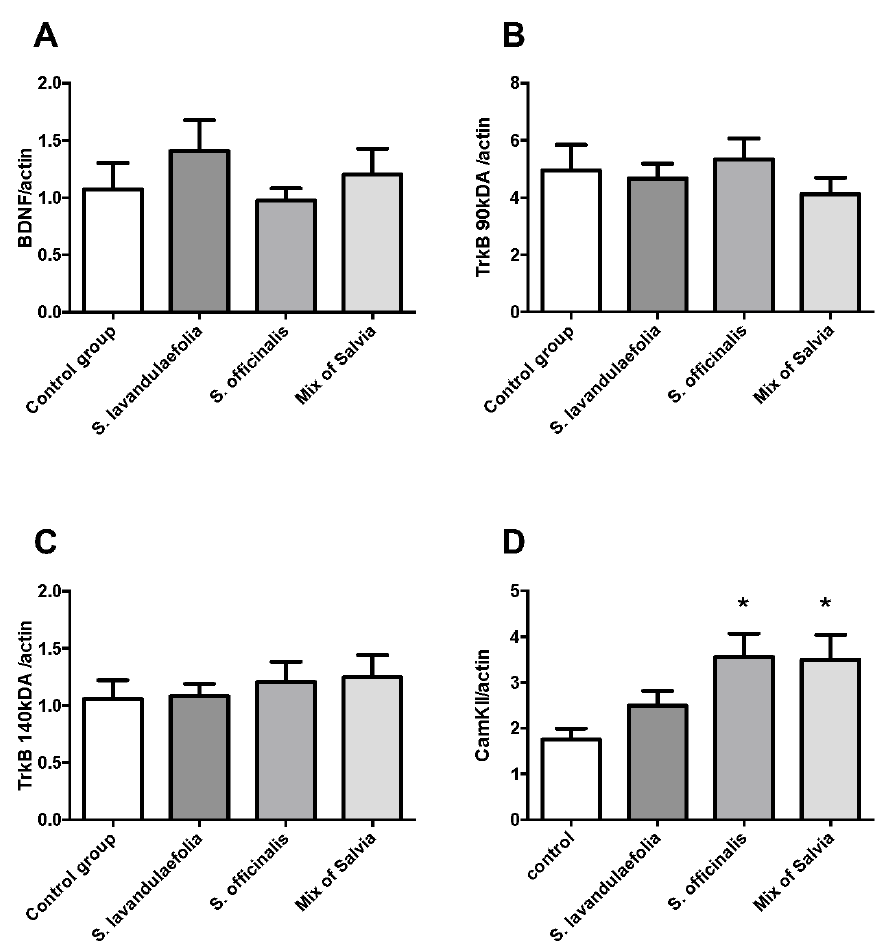
Figure 6. Chronic mix of Salvia supplementation did not impact neurotrophic factor but increase CaMKII protein expression. The protein expression of BDNF ( A ), TrkB (90kDa) ( B ), TrkB (140kDa) ( C ) and CamKII ( D ) compared to actin was evaluated by Western blot. All analyses were done using a one-way ANOVA (* p < 0.05 n = 6 per group).